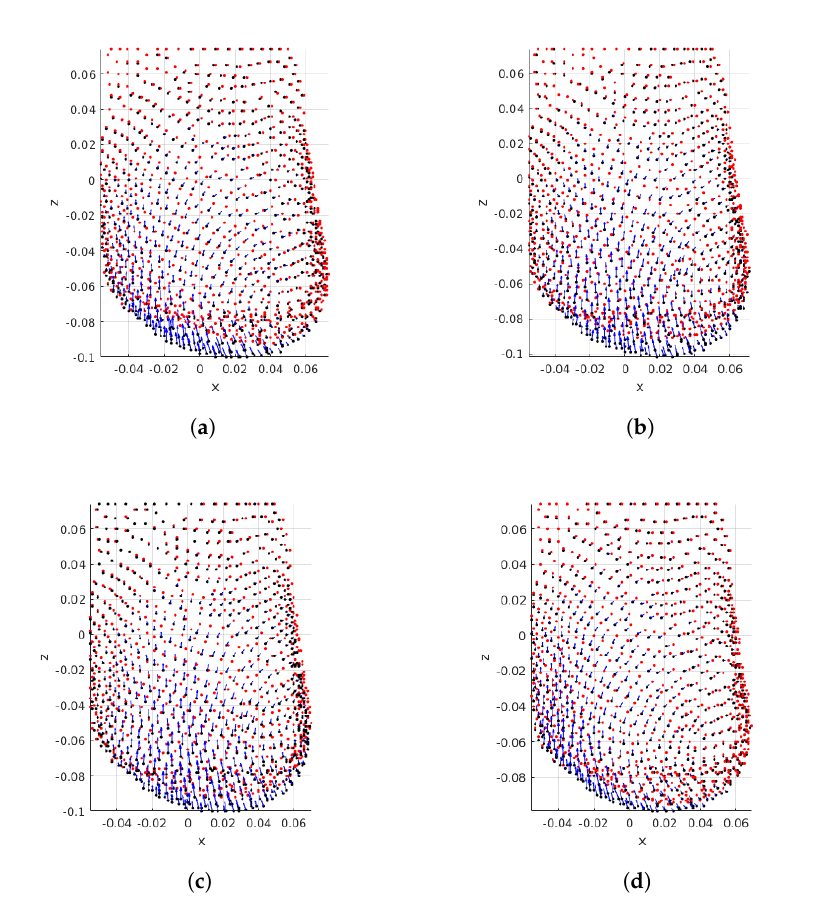
Figure 9. Influence of breast density on deformations: PCLs are shown for the same patient with variable breast density and fixed tumor position (UOQ) and size (small). Pre and post-surgical data on black and red, respectively. Blue arrows indicate displacement direction and magnitude. ( a ) BI-RADS A; ( b ) BI-RADS B; ( c ) BI-RADS C; ( d ) BI-RADS